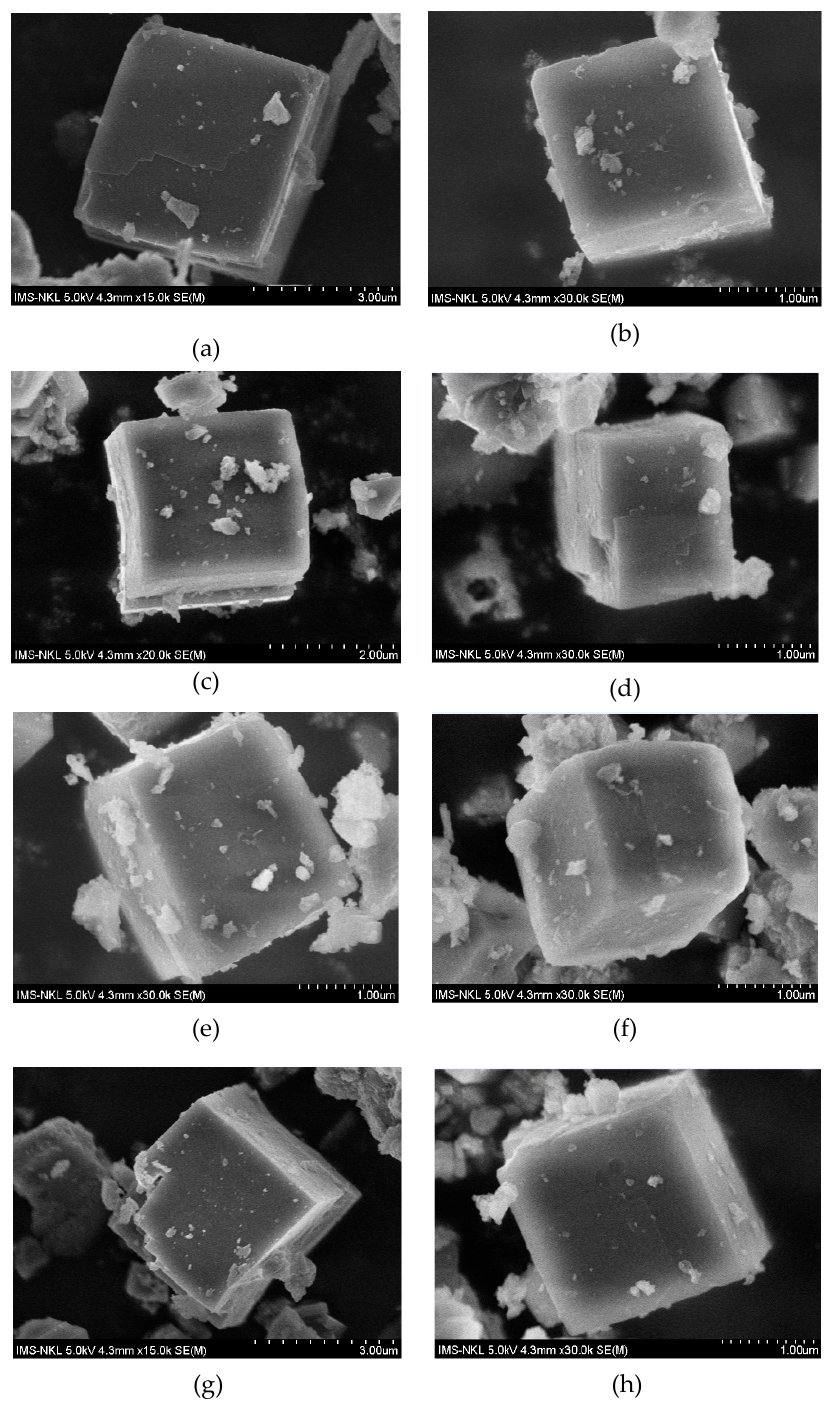
Figure 3 . FE-SEM images of ( a ) 1Cu/SAPO-34, ( b ) 1Fe/SAPO-34, ( c ) 3Cu/SAPO-34, ( d ) 3Fe/SAPO-34, Figure 3. FE-SEM images of ( a ) 1Cu / SAPO-34, ( b ) 1Fe / SAPO-34, ( c ) 3Cu / SAPO-34, ( d ) 3Fe / SAPO-34, ( e ) ( e ) 5Cu/SAPO-34, ( f ) 5Fe/SAPO-34, ( g ) 2Cu-2Fe/SAPO-34, ( h ) 3Cu-1Fe/SAPO-34. 5Cu / SAPO-34, ( f ) 5Fe / SAPO-34, ( g ) 2Cu-2Fe / SAPO-34, ( h ) 3Cu-1Fe /